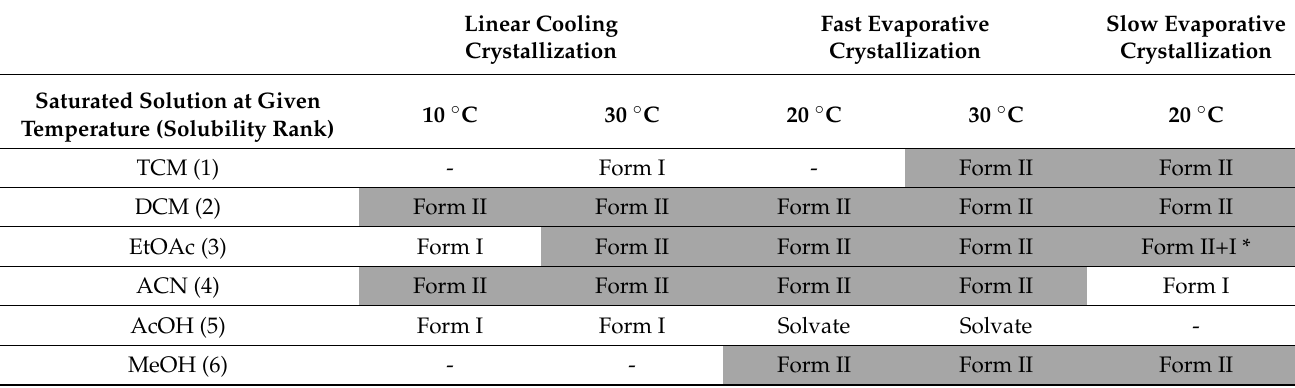
Table 2. Piroxicam polymorphic forms obtained from cooling and evaporative crystallizations. Linear Cooling Crystallization